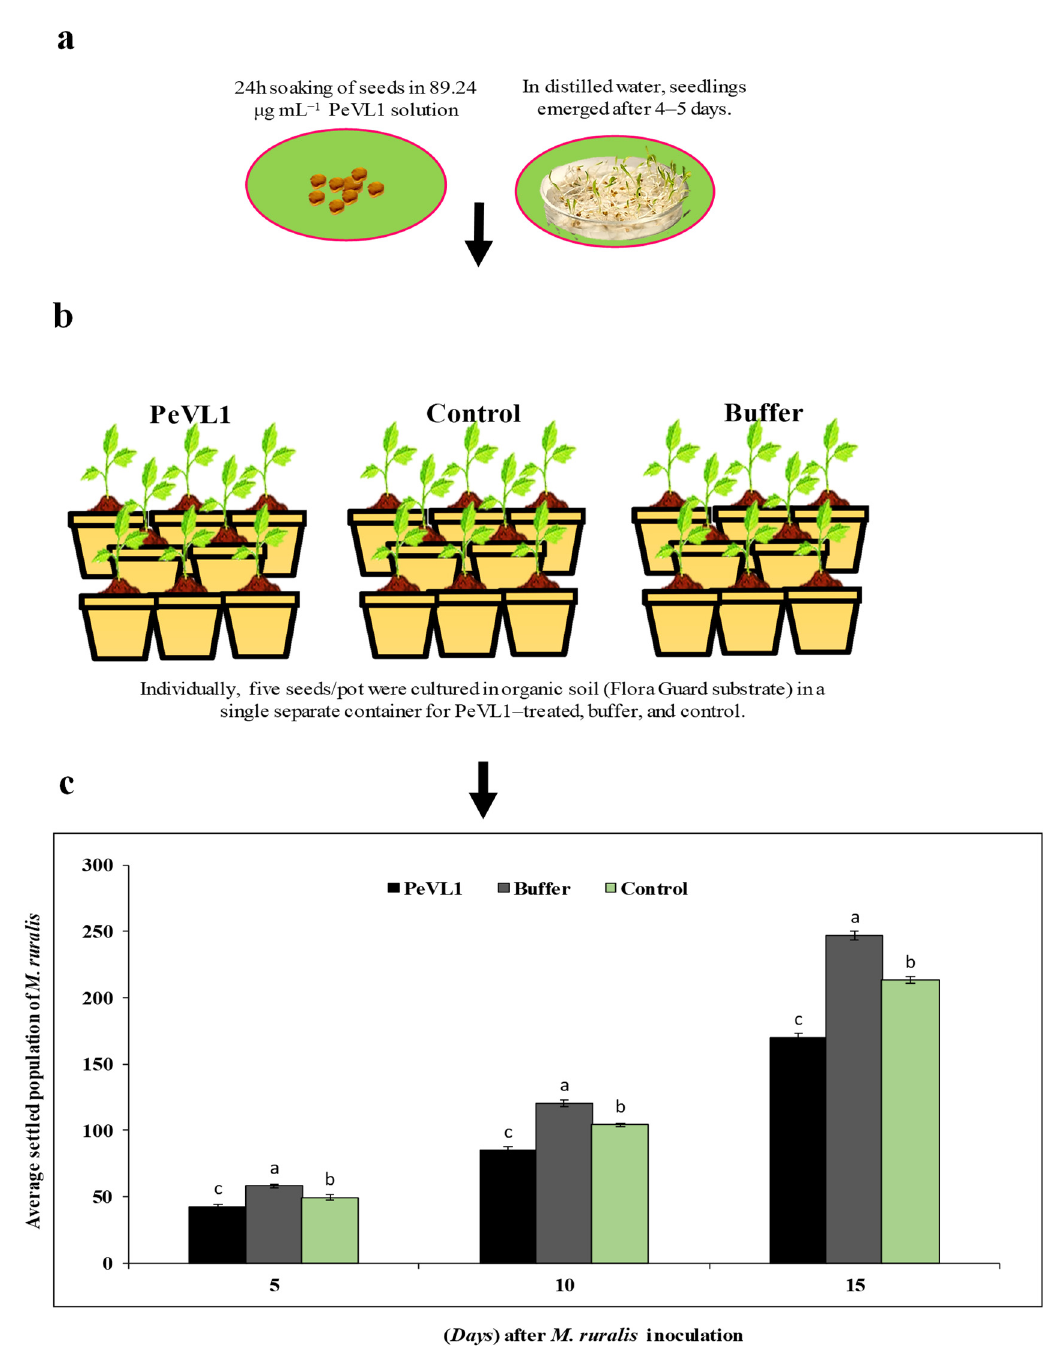
Figure 1. Marasmia ruralis population differences were observed in PeVL1-, control-, and buffer- treated O. sativa seedlings. Using one-way ANOVA, Levene’s test with SPSS 18.0, the LSD at p = 0.05. ( a , b ) Seeds and seedling treatment. ( c ) Seedlings treated with PeVL1 saw a substantial M. ruralis population loss (mean ± SD). ( a – c ) small letters on each bar are significant differences among treatments and control.